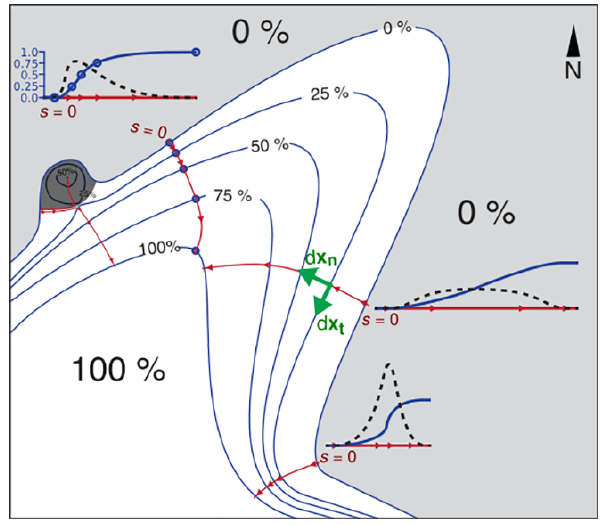
Figure 1. Schematic representation of a hypothetical probabilistic hazard map (PHM) where contours (blue) are the percent of de- terministic models inundating a given point in space. Steepest as- cent integral curves on the PHM ( x n (s) ) are shown in red. Profiles for the cumulative distribution φ( x n (s)) (blue) and the probability density d φ( x n (s))/ d s (black dashes) are represented schematically. The dark grey transparent region is the region of influence for the local maximum ( R m ) in which all integral curves terminate at the local maximum. Two integral curves (one inside of R m , one out- side of R m ) show the typical behavior of x n (s) near ∂ R m . The set e (cid:127) 0 is the entire white region, (cid:127) 0 is the region bounded by the zero level set (the white region plus the dark grey region), and (cid:127) 1 is the subset of that region which is marked with